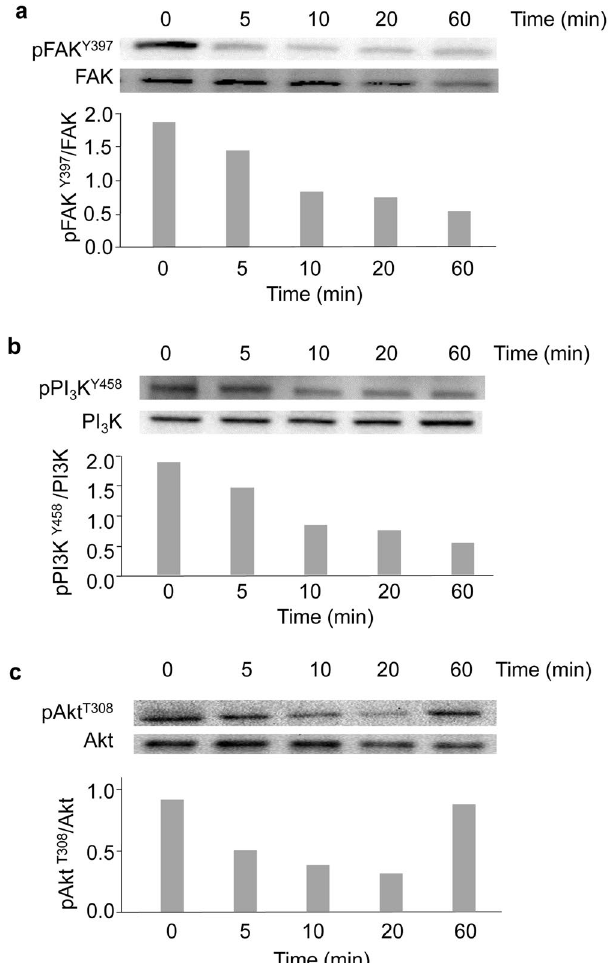
Figure 6. Kinetic analysis of FAK, PI 3 K p85 and Akt phosphorylation in SK-MEL-28 cells after incubation with QS-13. Western blot analysis of phosphorylated-FAK Y397 compared to total FAK ( a ), phosphorylated- PI 3 K p85 Y458 compared to total PI 3 K p85 subunit ( b ), phosphorylated-Akt T308 compared to total Akt ( c ). Bands were quantified by densitometric analysis and phosphorylated proteins were reported to corresponding total